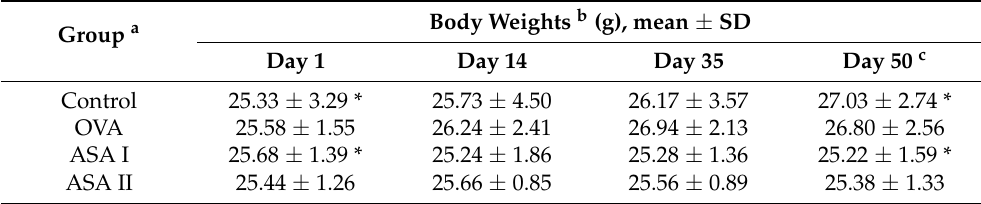
Table 2. Body weights of mice at different intervals of experiment during intranasal administration for mucosal